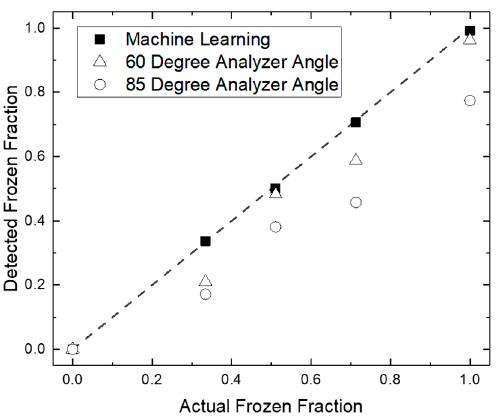
Figure 7. Comparison of the different methods for detecting frozen droplets. The dotted line denotes an ideal detection method i.e., where the method performs identical to a human operator.